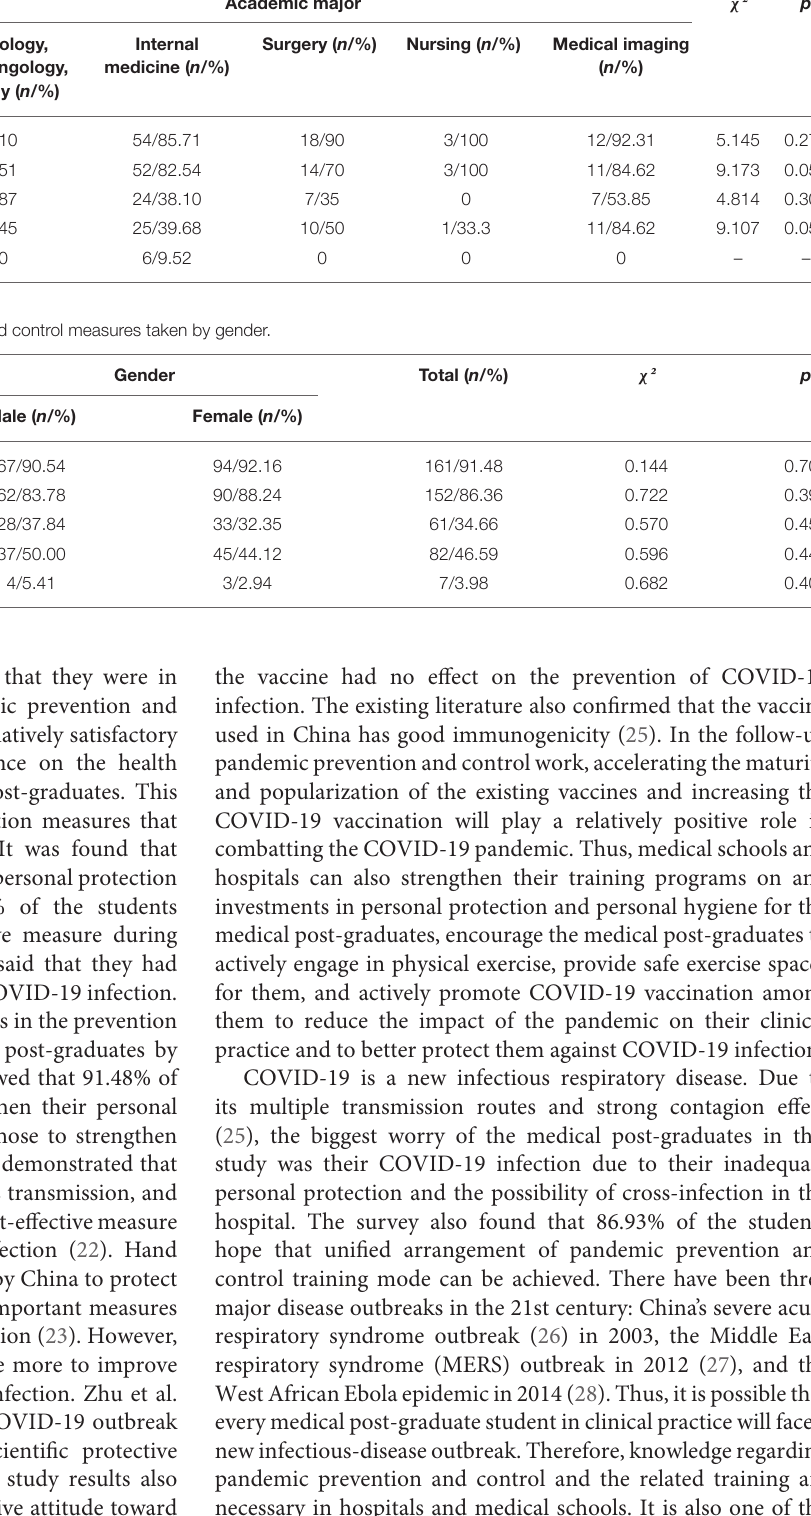
TABLE 4 | Comparison of the prevention and control measures taken by academic major. Protective measures taken